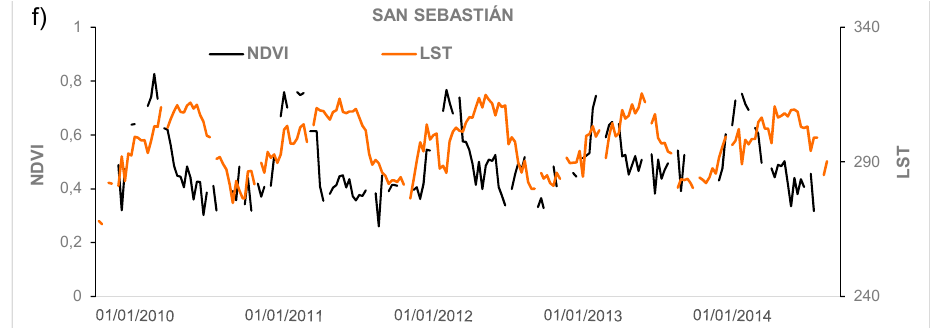
Figure 7. ( a – f ) Temporal evolution of NDVI-LST at three dry ( a , c , e ) and wet ( b , d , f ) locations. Only the NDVI-LSTday version was shown.